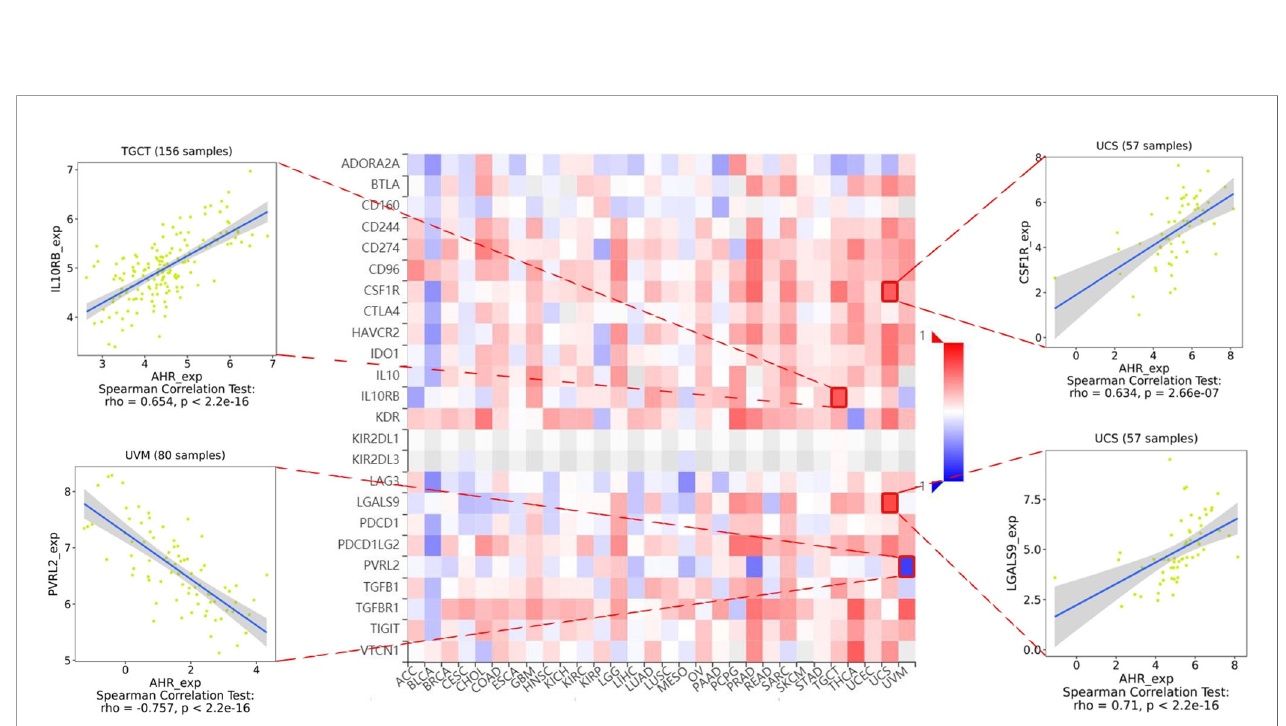
FIGURE 6 | The expression correlation between AhR and immune inhibitors. Red indicates positive correlation whereas blue indicates negative correlation. The top 4 strongest associations were displayed via